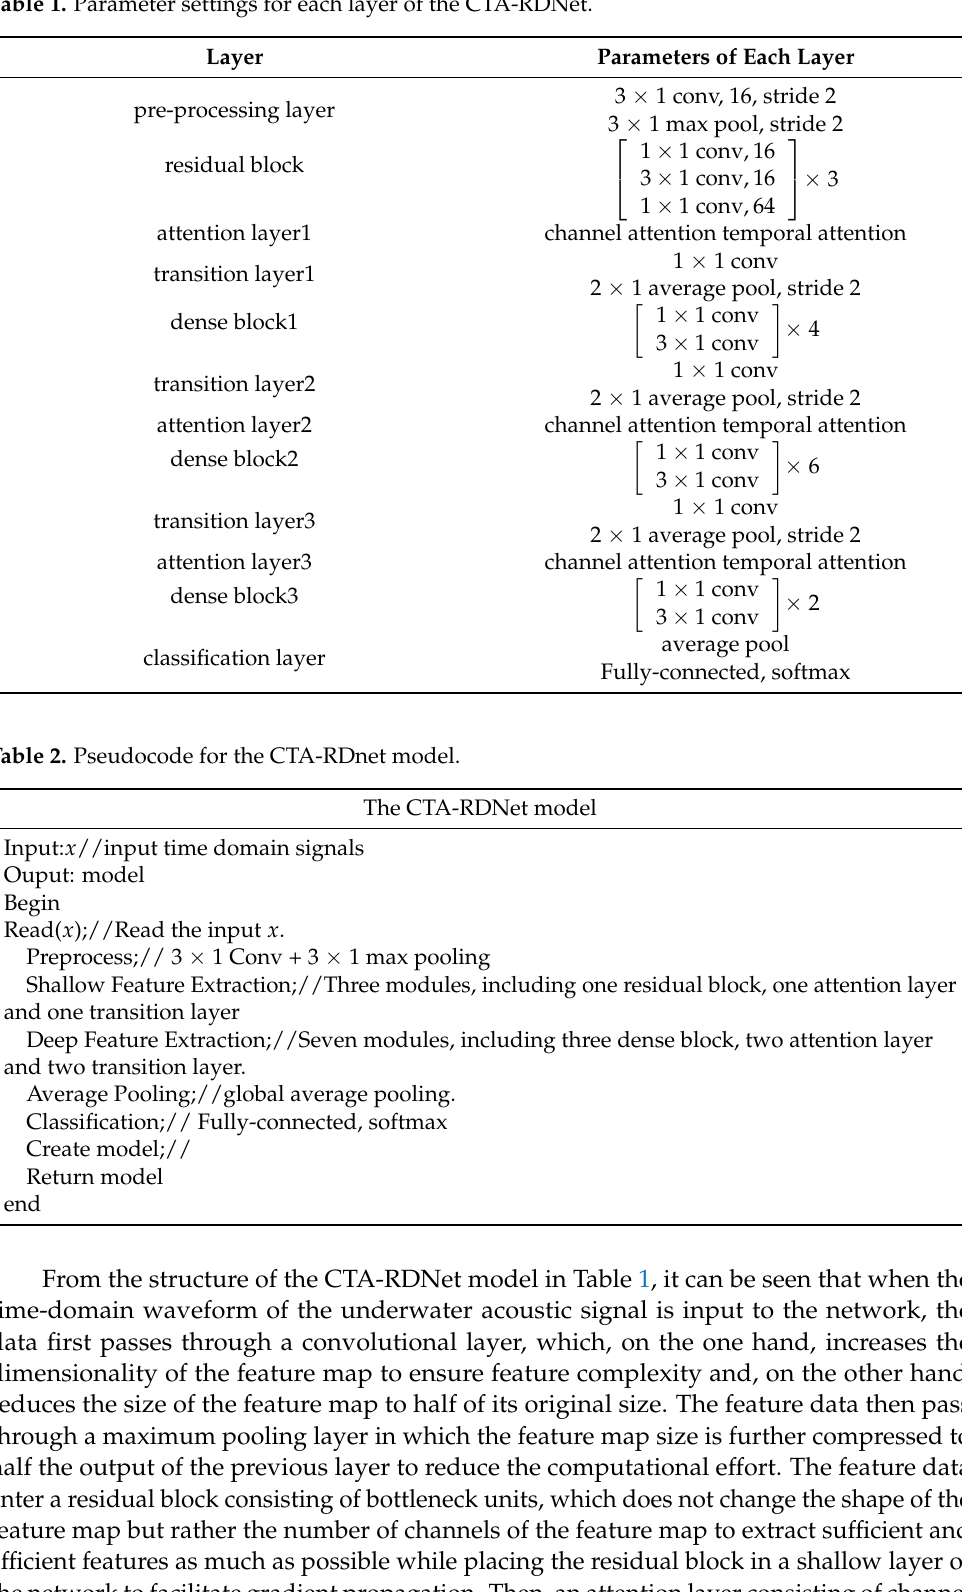
Table 1. Parameter settings for each layer of the CTA-RDNet.